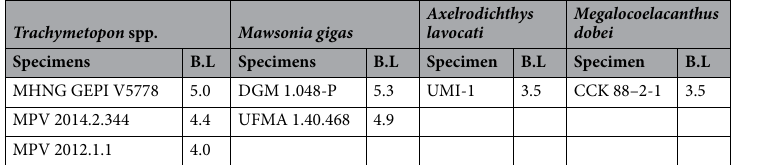
Table 1. Calculated body length (B.L., in meters) for some of the largest specimens of Trachymetopon spp., Mawsonia gigas , Axelrodichthys lavocati and Megalocoelacanthus dobei .